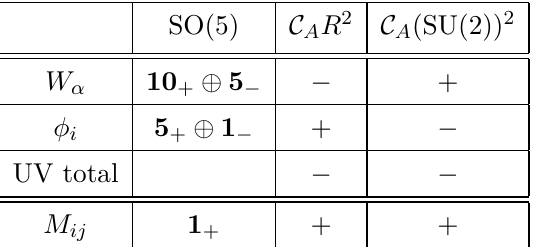
Table 12 . The first column is the quantum number under the P -invariant subgroup Sp(4) = SO(5) . Anomalies of charge conjugation do not match, indicating that the charge conjugation is spontaneously broken. These anomalies were not studied